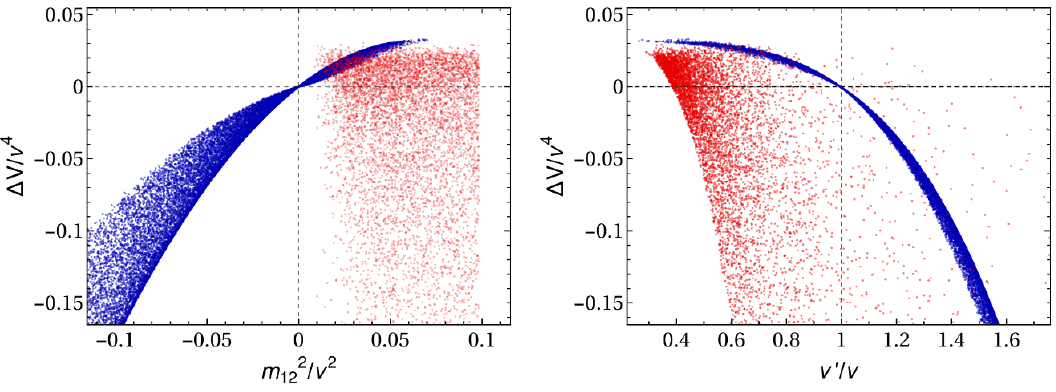
Figure 1 . Left : potential di(cid:11)erence (2.4) at the two coexisting minima against m 2 ized by v = 246 GeV. Right : the same depth di(cid:11)erence against the ratio of non-standard vev (NV 0 ) to the standard vev